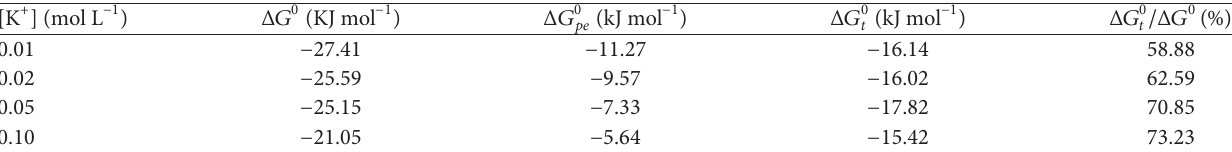
T 3: e effect of salt concentration (KCl) on free energy changes (